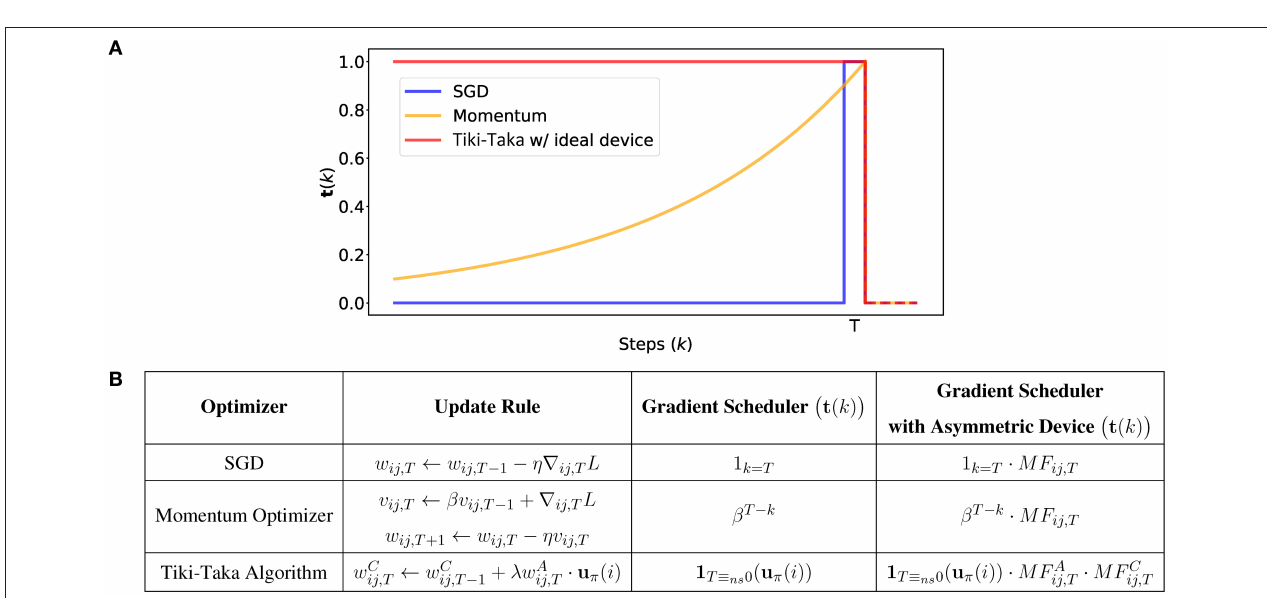
FIGURE 2 | The train error (A) and test error (B) on handwritten digits images (MNIST) dataset with MLP. The baseline indicates the averaged error of the last 3 epochs with symmetric linear device, and the neural network is trained with SGD. In the case of SGD with asymmetric non-linear device, the error is averaged over various AF > 0. In the case of Tiki-Taka algorithm, the error is averaged over various pair of SGD and transfer learning rates. The shaded area indicates standard deviation.